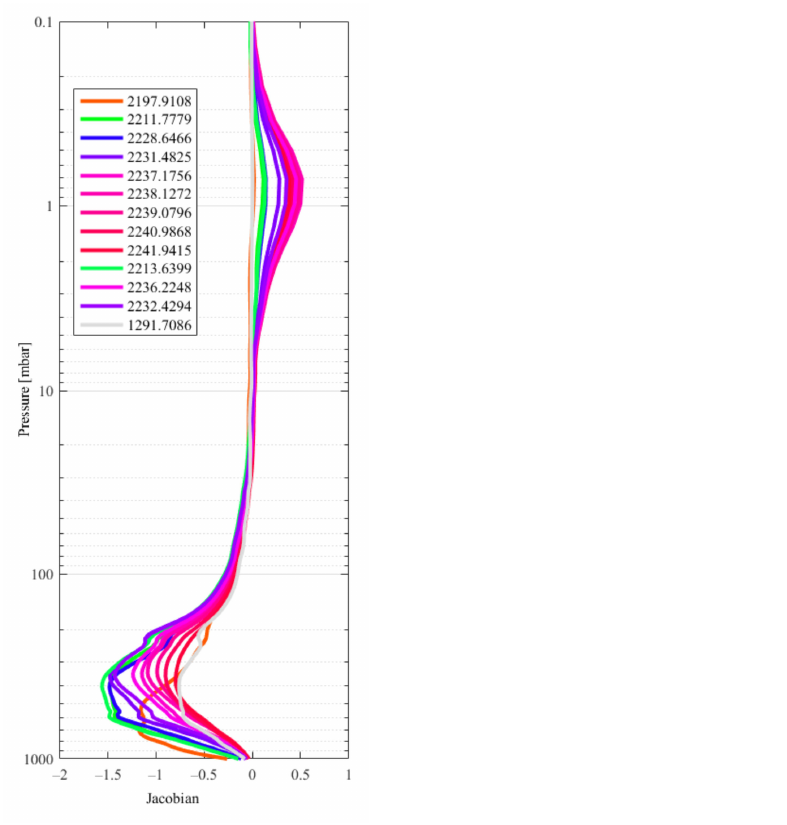
Figure 7. Weighting functions of all the channels selected for retrieval.